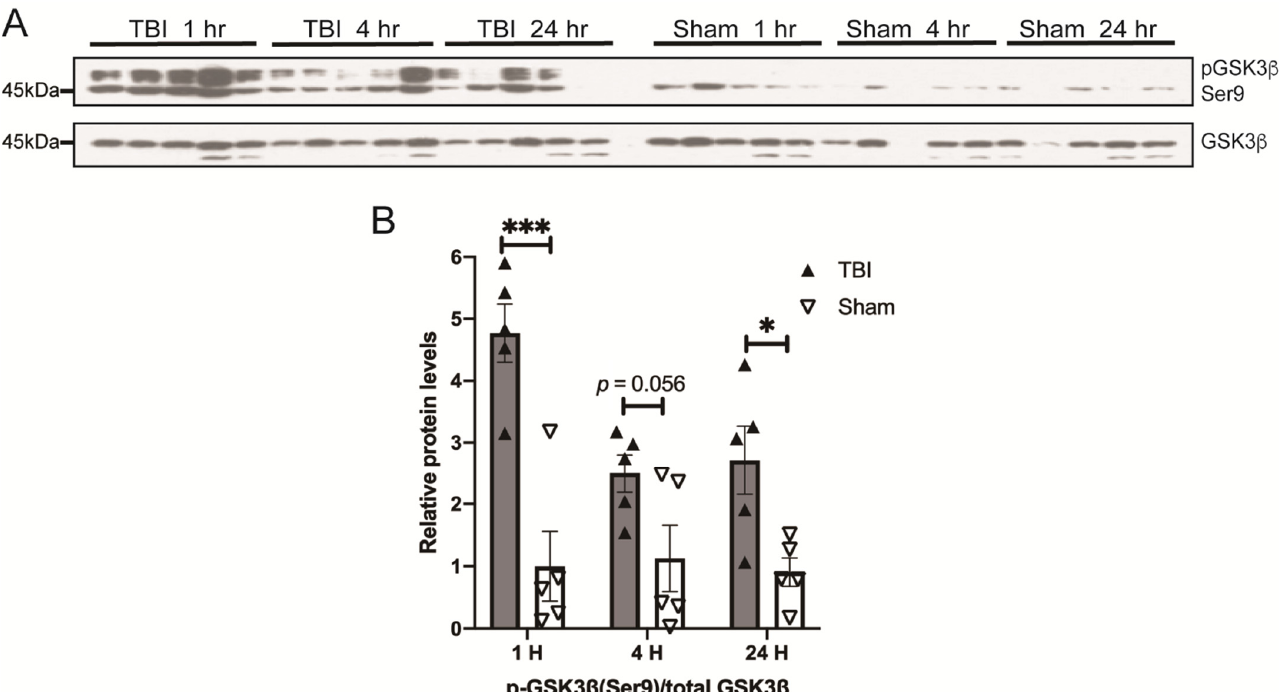
Figure 3. BOP caused the inhibition of glycogen synthase kinase-3 β (GSK3 β ) in the mouse brain. Representative Western blots ( A ) and quantification analysis ( B ) revealed the inhibition of GSK3 β after blast ( n = 5/group). (Data are means ± SEM, * p < 0.05, *** p < 0.001).